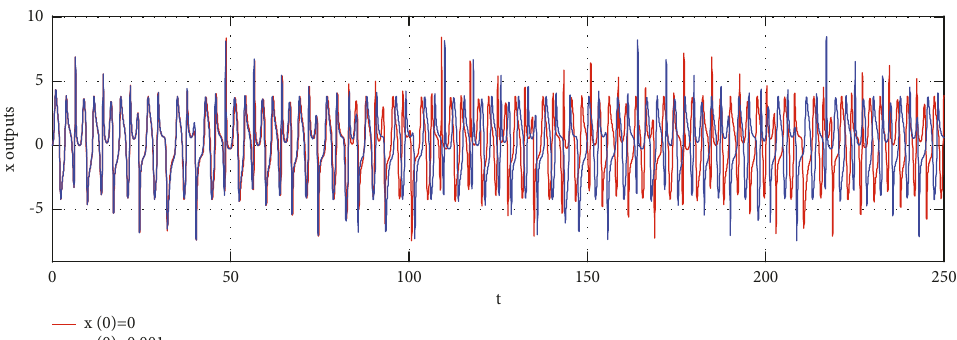
Figure 6: Sensitivity to initial conditions for x